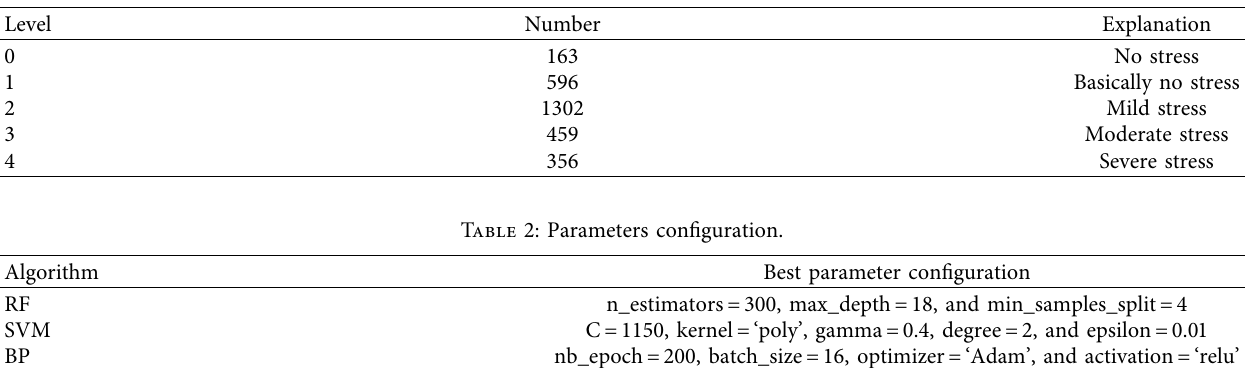
Figure 1: The process of the XGBoost algorithm. Table 1: Stress labels.